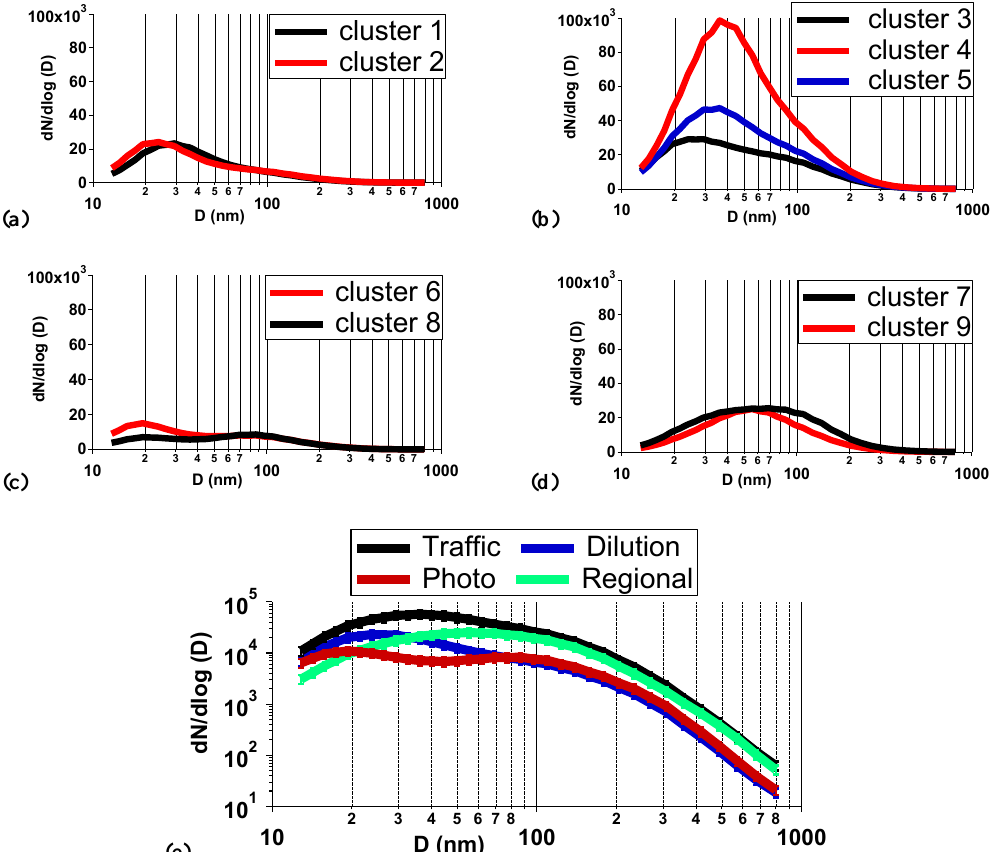
Fig. 3. K-means clusters for (a) Dilution, (b) Traffic, (c) Photochemical, (d) Regional and (e) Average number aerosol size distributions for each of the four